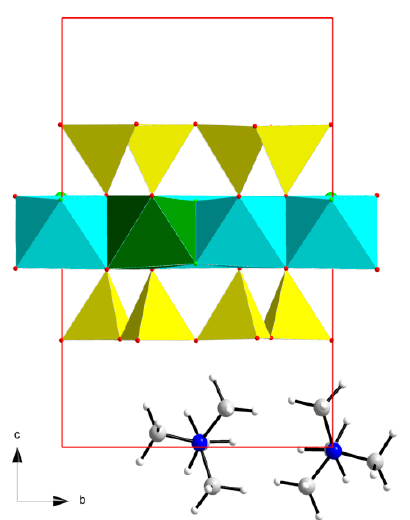
Figure 1. Optimized L model of the TMAH structure: ( − x , − y , − z ) Wyckoff position of the first TMA cation (a 4 for A type), ( x + 0.5, y + 0.5, z ) Wyckoff position of the second TMA cation (a 5 for A type) as an example (Si-tetrahedra in yellow, Mg-octahedra in cyan and Li-octahedra in green. N atoms in blue, C-atoms in light grey, O atoms in red, H atoms in white and F atoms in light green). Table 1. X, Y Wyckoff position, 8 j , for atoms in A and/or B types of TMA cation, respectively. X, Y Position A Cation B Cation